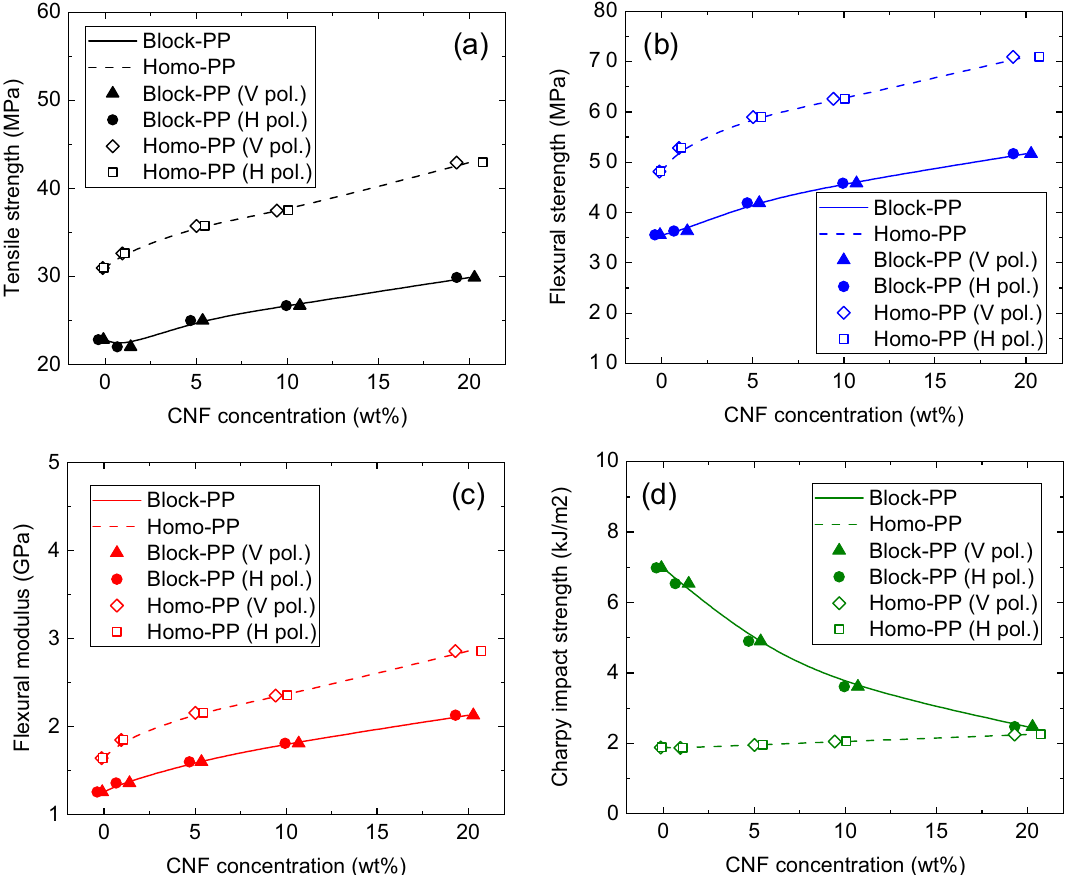
Figure 8. Relationship between mechanical properties and CNF concentration of block-PP (solid line) and homo-PP (dashed line), CNF concentration in block-PP estimated from the THz absorption coefficient obtained with vertical polarization (triangle), CNF concentration in block-PP estimated from THz absorption coefficient obtained with horizontal polarization (circle), CNF concentration in homo-PP estimated from THz absorption coefficient obtained with vertical polarization (diamond), CNF concentration in homo-PP estimated from THz absorption coefficient obtained with horizontal polarization (square): ( a ) Tensile strength, ( b ) flexural strength, ( c ) flexural modulus, ( d ) Charpy impact